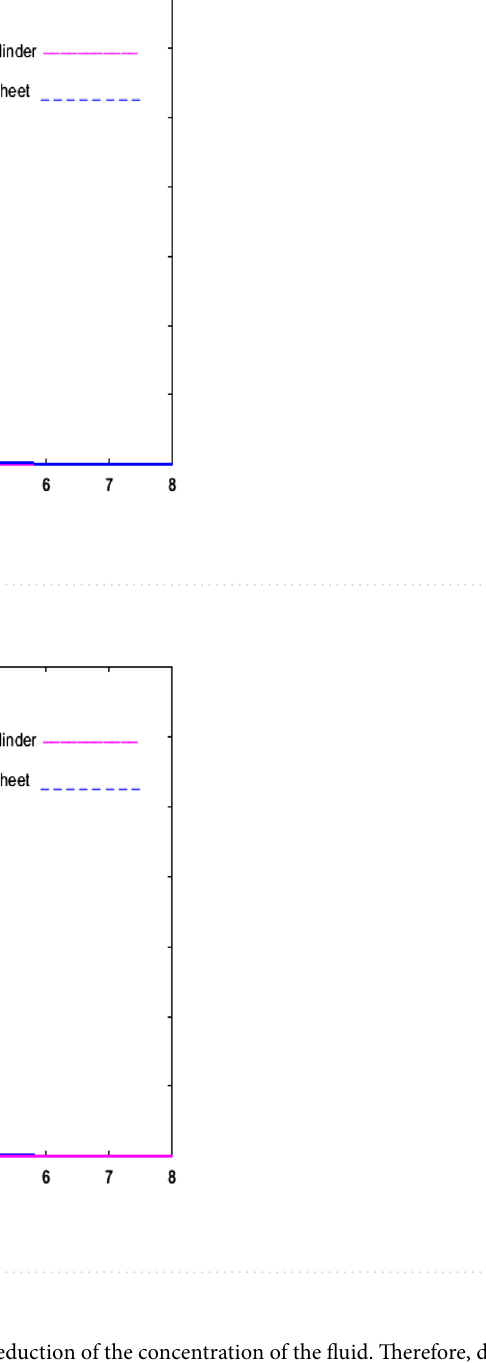
to concentration. On escalating S r , the temperature gradient rises. It is perceived that molecular diffusion increases. Thus, the rate of mass transfer intensifies for growing values of S r . Consequently, φ(ζ) enhances.